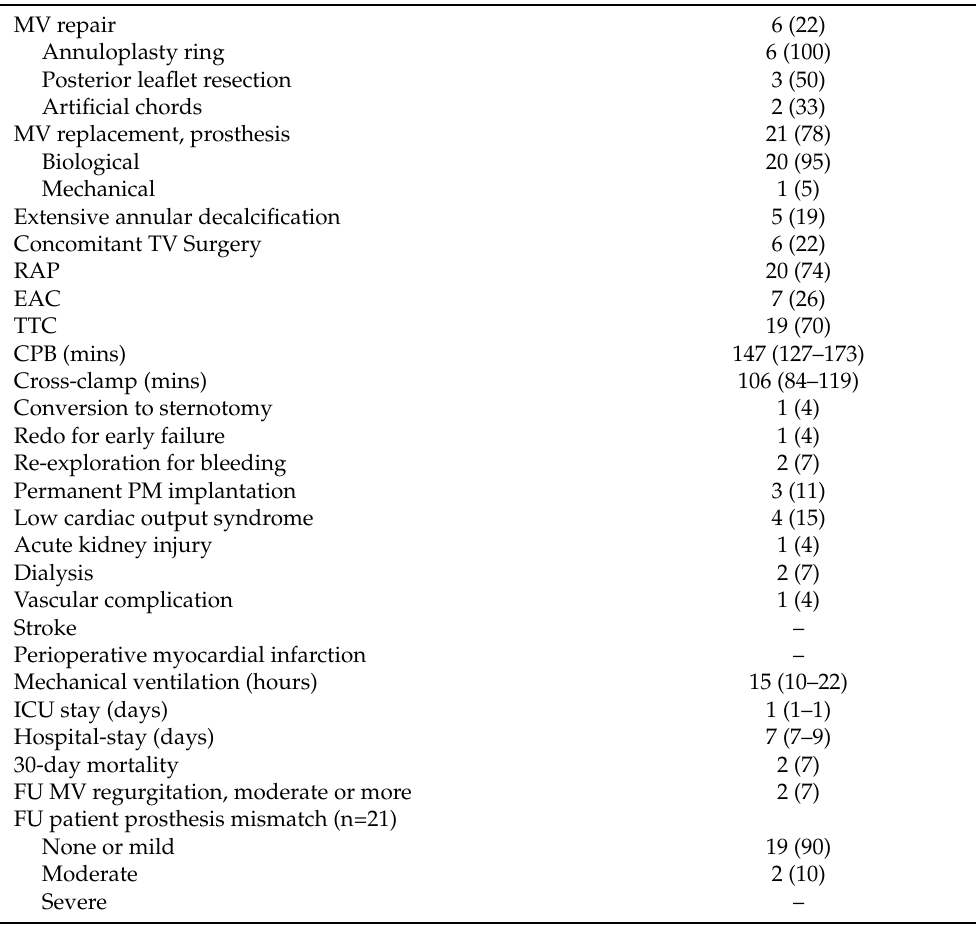
Table 3. Intraoperative variables and postoperative outcomes (n =